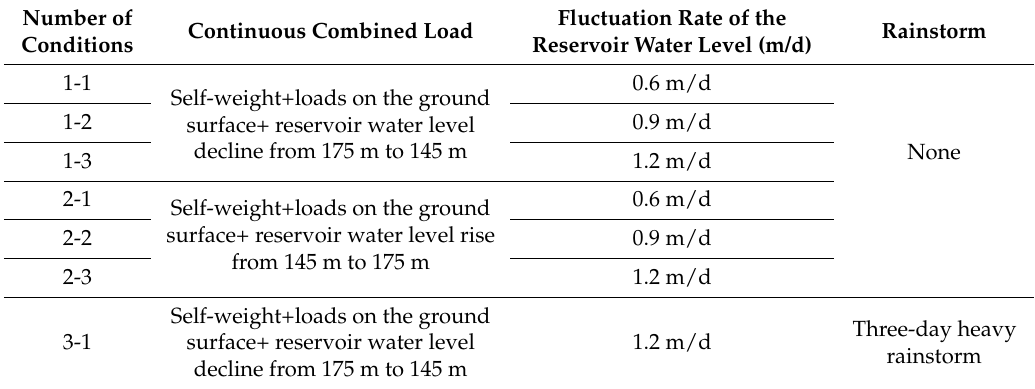
Table 2. Different combinations of operating conditions for landslide stability calculations.